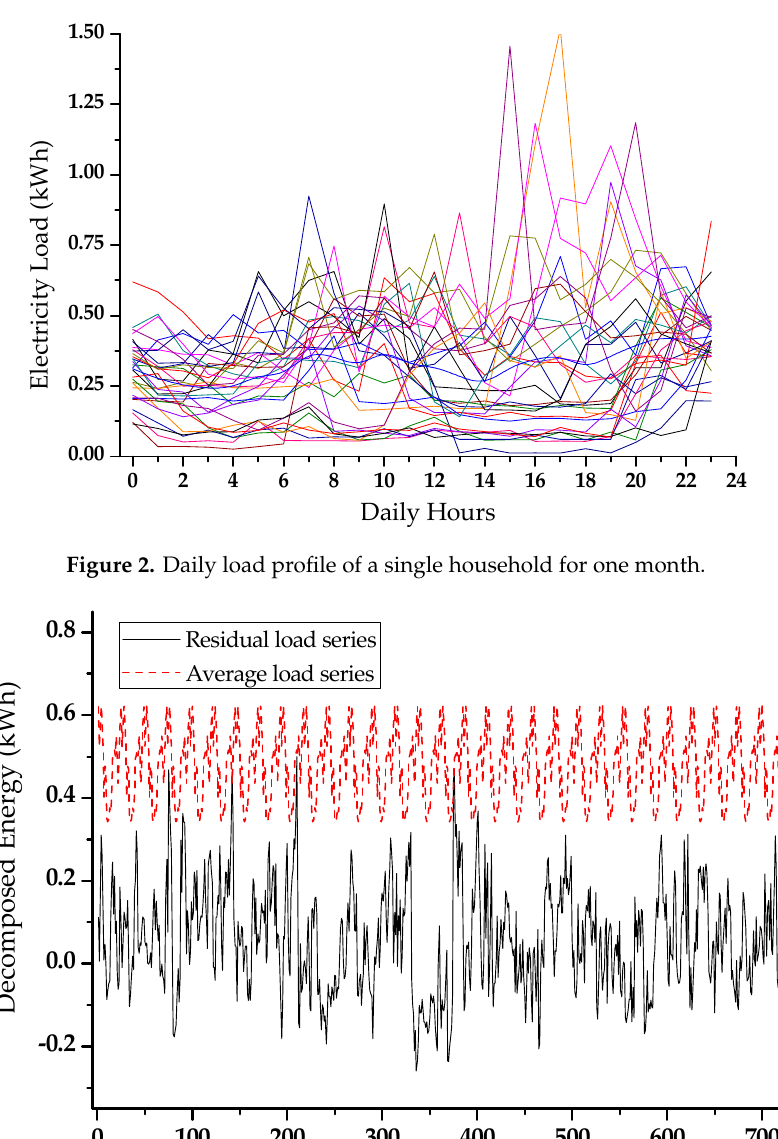
Figure 2. Daily load profile of a single household for one month.